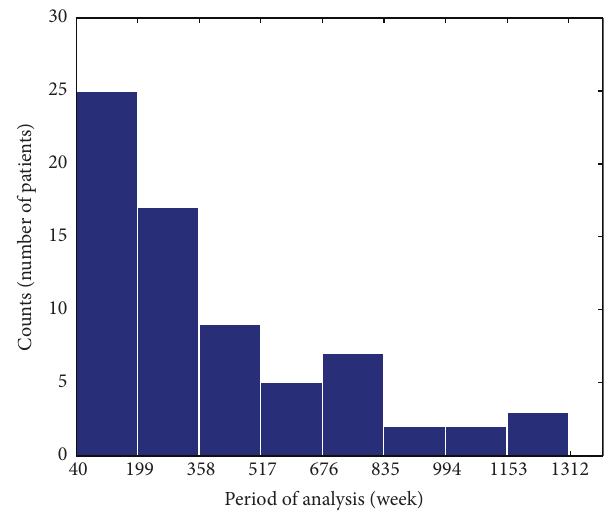
Figure 3: Histogram of the duration of the relapsing-remitting phase in weeks for the 70 selected patients. The duration of the relapsing-remitting phase (i.e., analysis period) varies from one patient to the other, from a minimum of 40 weeks to a maximum of 1311 weeks, following an exponential decaying distribution. For 25 of 70 selected patients (about 36%), the relapsing-remitting phase lasts for about 200 weeks (about 4